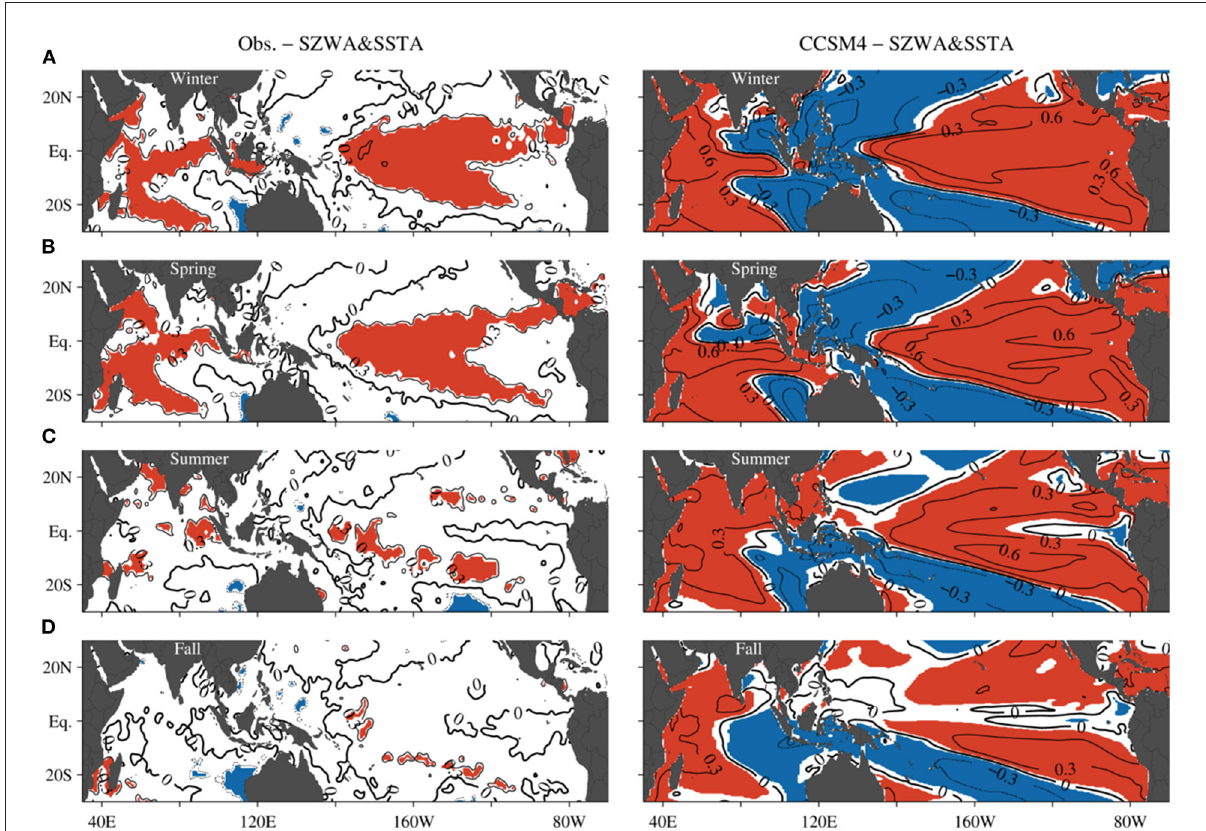
FIGURE10 Comparison of observed (left column) and simulated (right column) lag correlations between the SZWA over the far western equatorial Pacific in fall and the tropical Indo-Pacific SSTA in the following four seasons during the positive phases of the decadal variability (from 1948 to 2009 in the observation). (A) Winter (December to February). (B) Spring (March to May). (C) Summer (June to August). (D) Autumn (September to November). The contour interval is 0.3. Red and blue shades indicate 95% confidence level of positive and negative correlation,